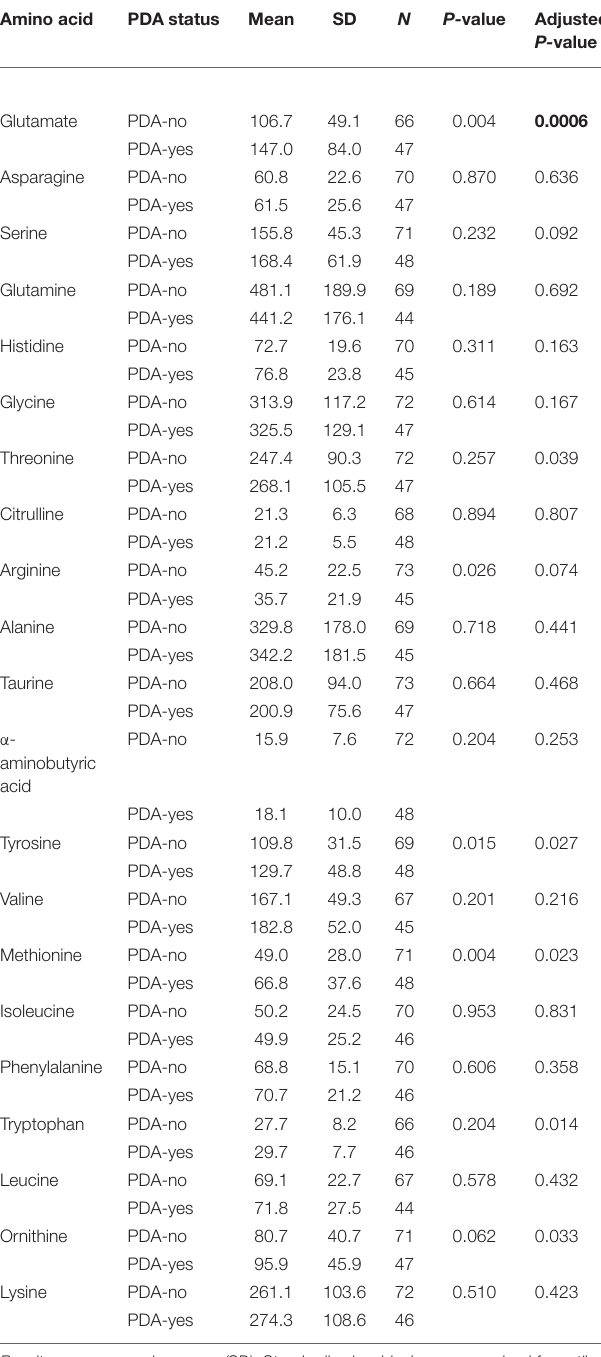
TABLE 3 | Plasma concentrations of glutamate ( µ mol/L) in different characteristics and outcomes of preterm infants. Characteristic/